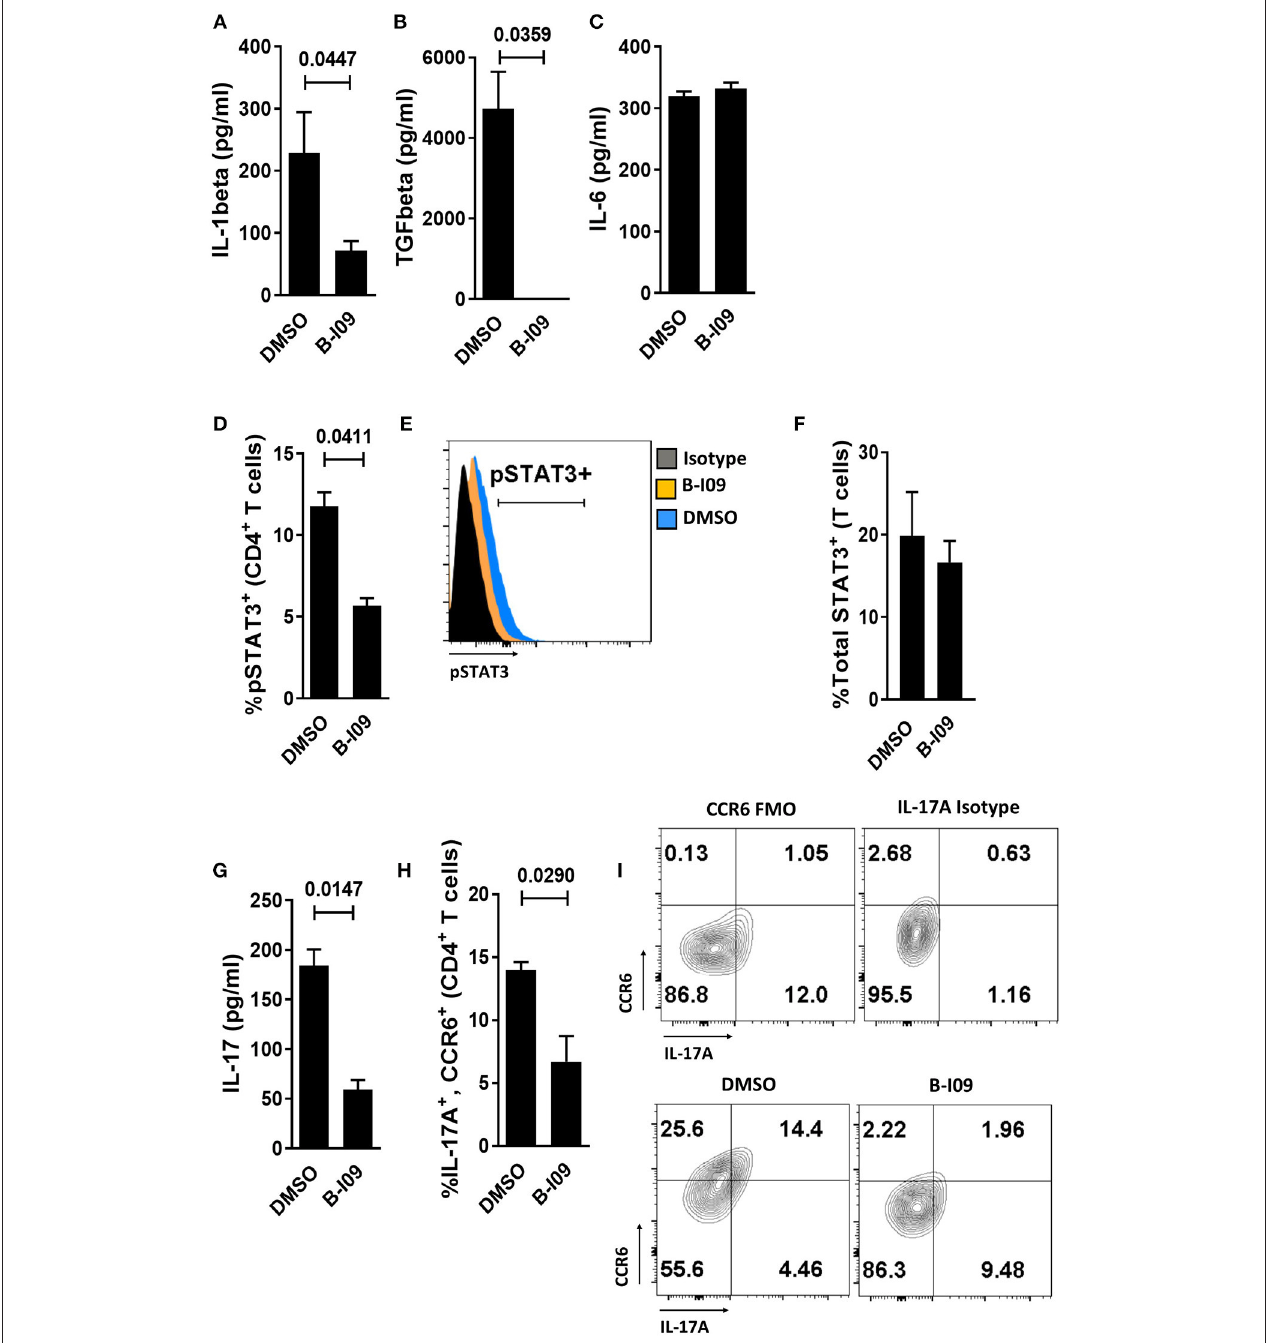
FIGURE 3 | Targeting XBP-1s abrogates human moDC production of IL-1 β , TGF β , and diminishes alloresponder Th17 differentiation . (A–C) Supernatant concentrations of IL-1 β , TGF β , or IL-6 from LPS-stimulated moDCs exposed to B-I09 or DMSO after 24h of culture are shown. Replicate means from 5 (IL-1 β ), 3 (TGF β ), and 4 (IL-6) independent experiments are shown, paired t -test. (D–H) T cells were cultured with B-I09 or DMSO pre-treated moDCs (moDC:T cell ratio of 1:30), and additional B-I09 (20 µ M) or DMSO (0.1%) was added once on day 0. pSTAT3 + CD4 + T cells were analyzed at day + 5 by flow cytometry (D) and representative histograms are shown (E) . Means from 3 independent experiments are shown, paired t -test. (F) Total STAT3 was measured in T cells from co-cultures of DCs and T cells treated with B-I09 or DMSO. Means from 3 experiments are shown. In similarly treated co-cultures, the supernatant concentration of IL-17 was quantified (G) and Th17 (CD4 + , CCR6 + , IL-17A + ) differentiation was evaluated by flow cytometry (H,I) . Replicate means from 3 (IL-17 ELISA) and 4 (Th17) independent experiments, paired t -test. (I) Representative contour plots are shown.